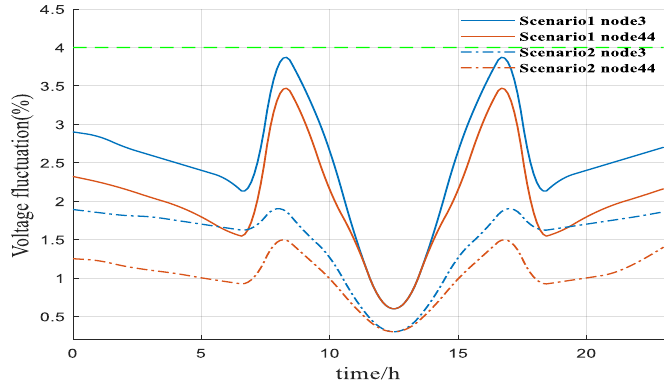
Figure 12. Voltage fluctuation curve.